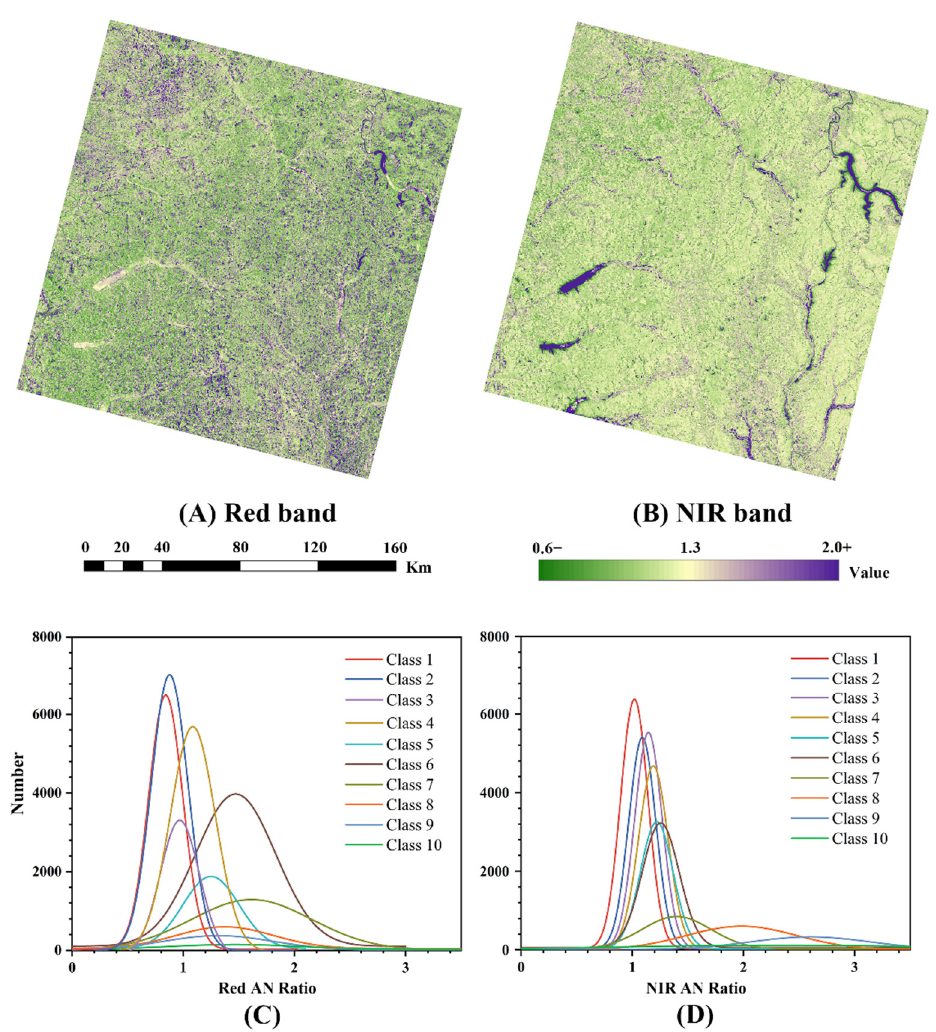
Figure 2. Spatial distribution of the ratio of MODIS WSA (white-sky albedo, after converting spectral coefficients) to Landsat nadir reflectance, and histograms of AN ratio (Albedo-to-Nadir reflectance ratio), obtained by unsupervised classification, in Northwest Mississippi, on 9 April 2014. ( A) : red band AN ratio; ( B) : near-infrared band AN ratio; ( C) : histograms of red band AN ratio; ( D) : histograms of near-infrared band AN ratio.